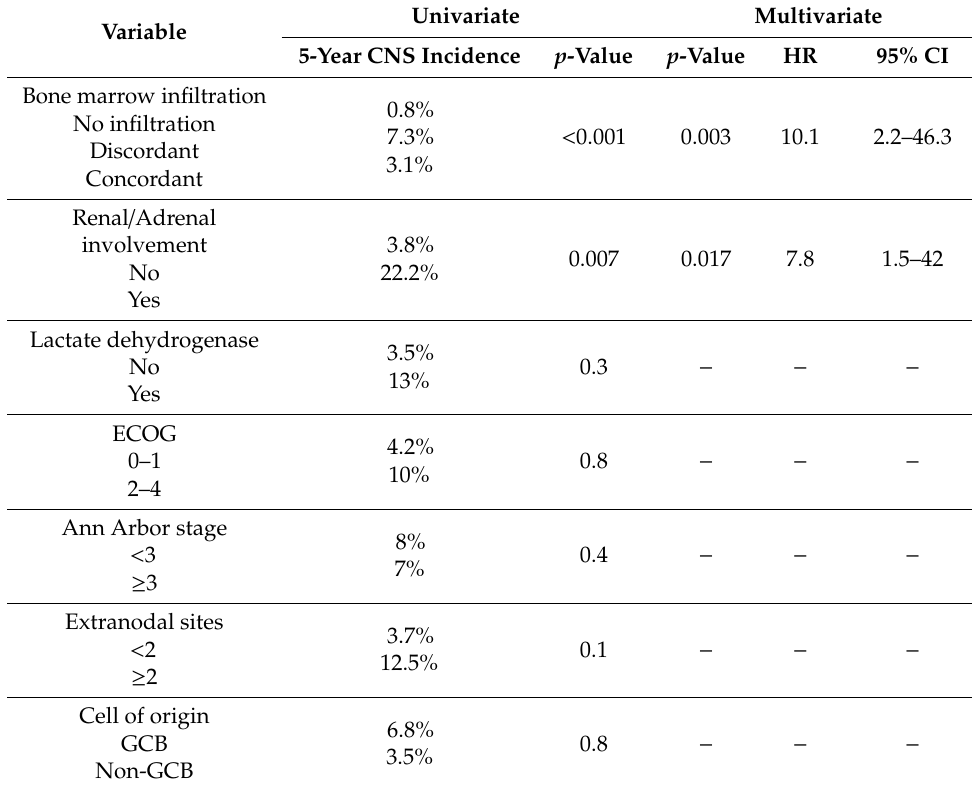
Table 5. Univariate and multivariate analysis of central nervous system relapse incidence. Univariate Multivariate Variable 5-Year CNS Incidence p -Value p -Value HR 95% CI Bone marrow infiltration 0.8% No infiltration < 0.001 0.003 10.1 2.2–46.3 7.3% Discordant 3.1% Concordant involvement 3.8% 0.007 0.017 7.8 22.2%